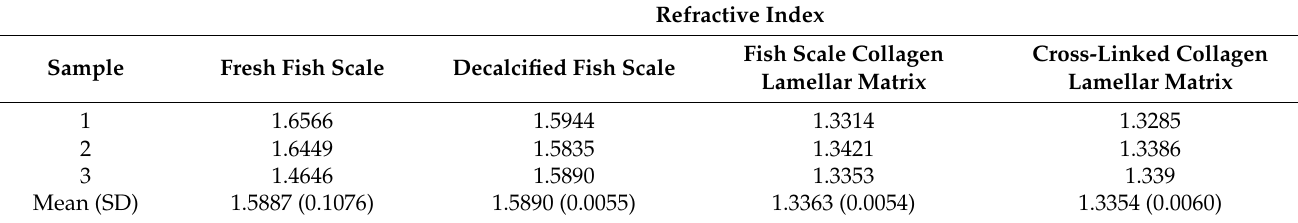
Table 4. Refractive index of different